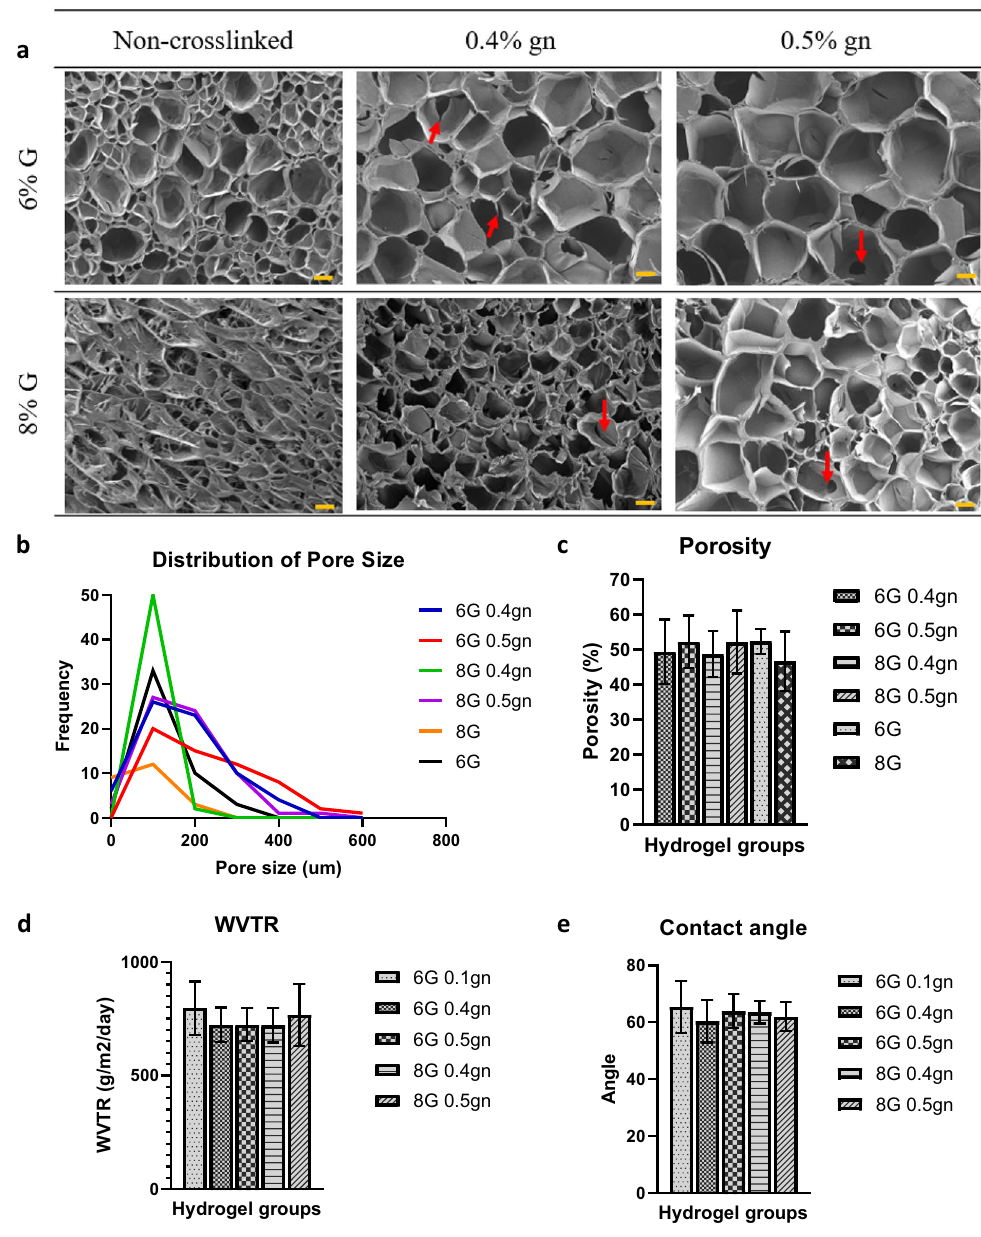
Figure 2. Microporous structure of the genipin-crosslinked gelatin hydrogels. ( a ) Scanning electron microscopy of the gelatin hydrogel (cross-sectional view) at 50 × magnification. Red arrow indicates interconnected pores. Each yellow scale bar represents 100 μm. ( b ) Pore size distribution of the genipin- crosslinked gelatin hydrogels. ( c ) Porosity of the genipin-crosslinked gelatin hydrogels. ( d ) WVTR of the genipin-crosslinked gelatin hydrogels. ( e ) Water contact angle of genipin-crosslinked gelatin